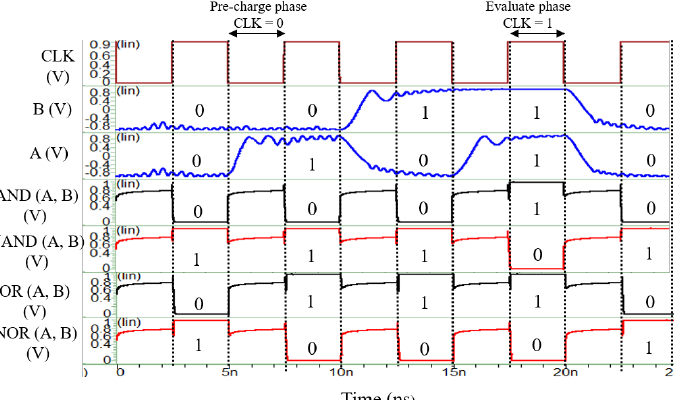
Figure 5. Transient response of logic operations AND, NAND, OR, and NOR where CLK is input clock pulse, A and B input logic values, AND (A, B), NAND (A, B), OR (A, B), and NOR (A, B) are the logical AND, NAND, OR, and NOR values between inputs A and B.